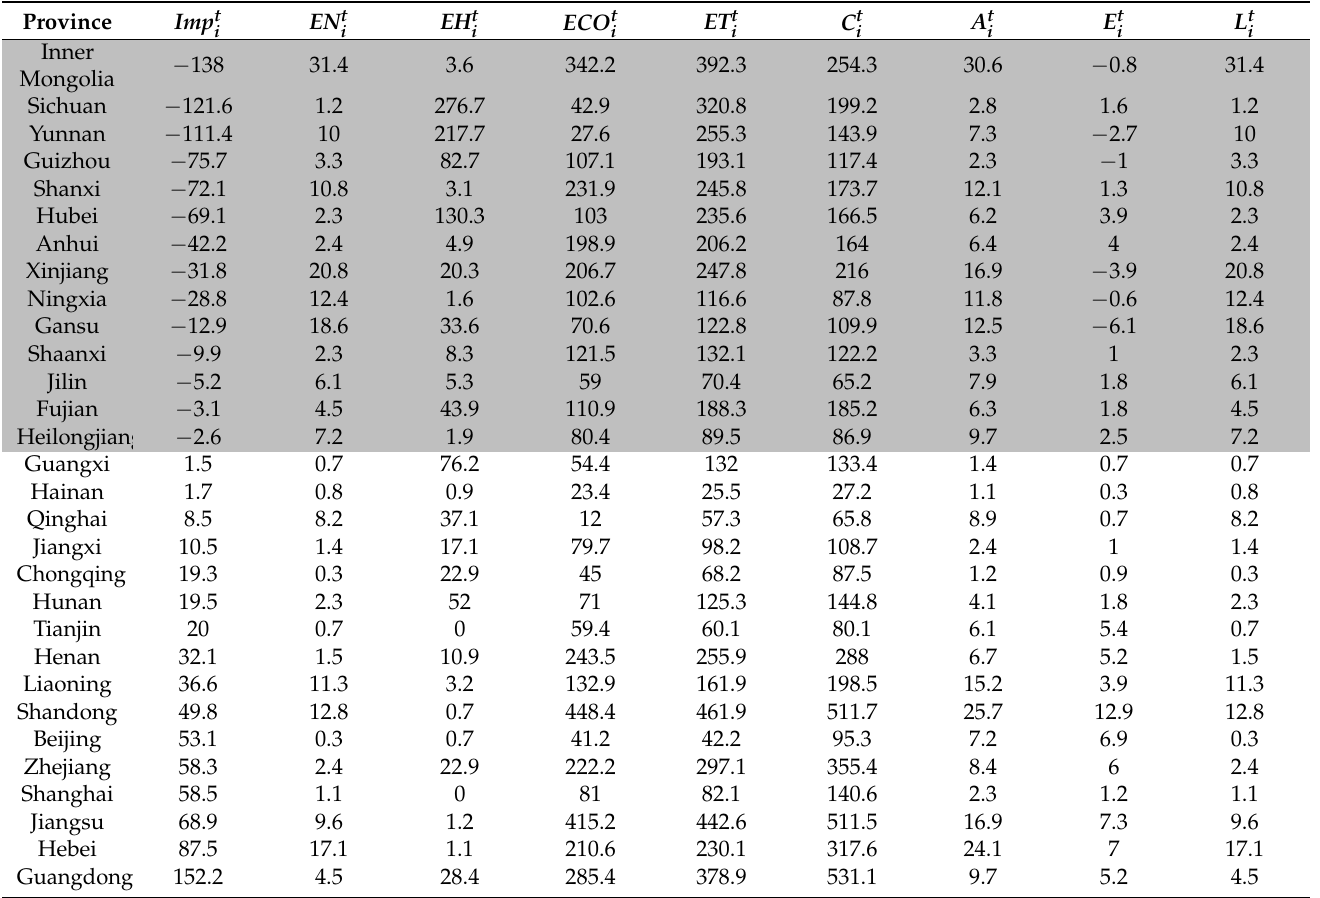
Table A1. Structural data of provincial electricity balance and accommodation, 2015 1,2 .